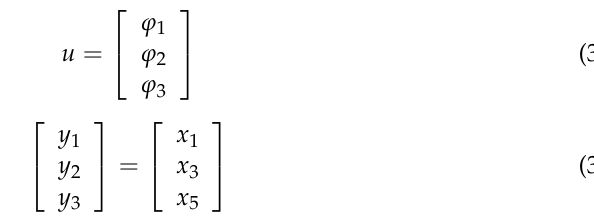
Figure 8. Decoupled control schemes.